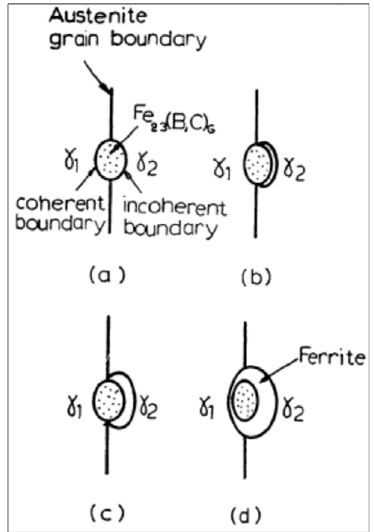
Figure 1. Schematic diagram of ferrite nucleation and growth at Fe